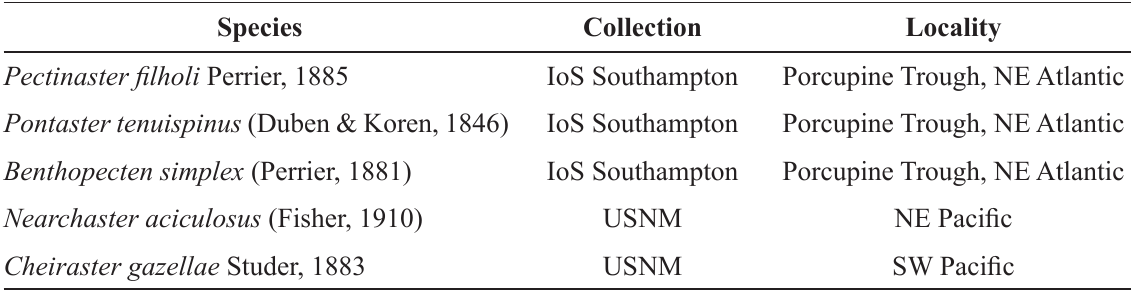
Table 1. Modern benthopectinids used for present